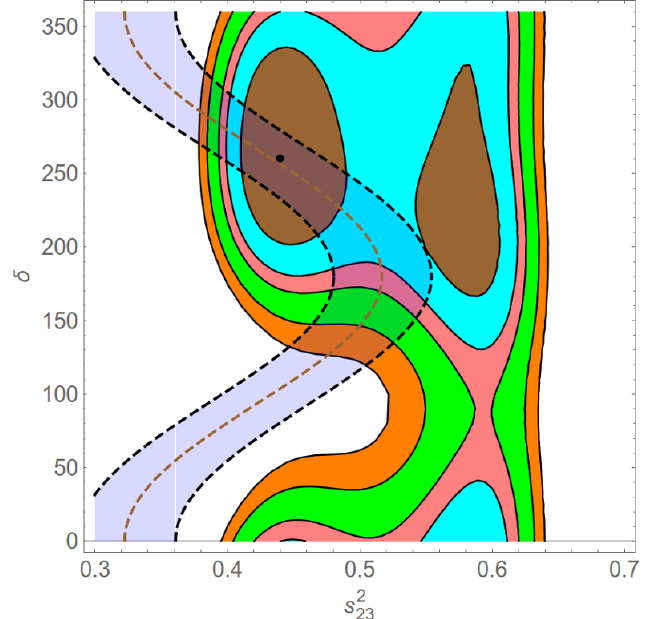
Figure 4 . The (cid:23) (cid:12)t results [61, 62] for the global (cid:12)t to neutrino data (coloured contours correspond to 68.27% 90% 95.45% 99% 99.73% C.L. regions in the s 2 model for central values of the rest of the mixing parameters (brown dashed line) and the band obtained when they are varied in 1 (cid:27)